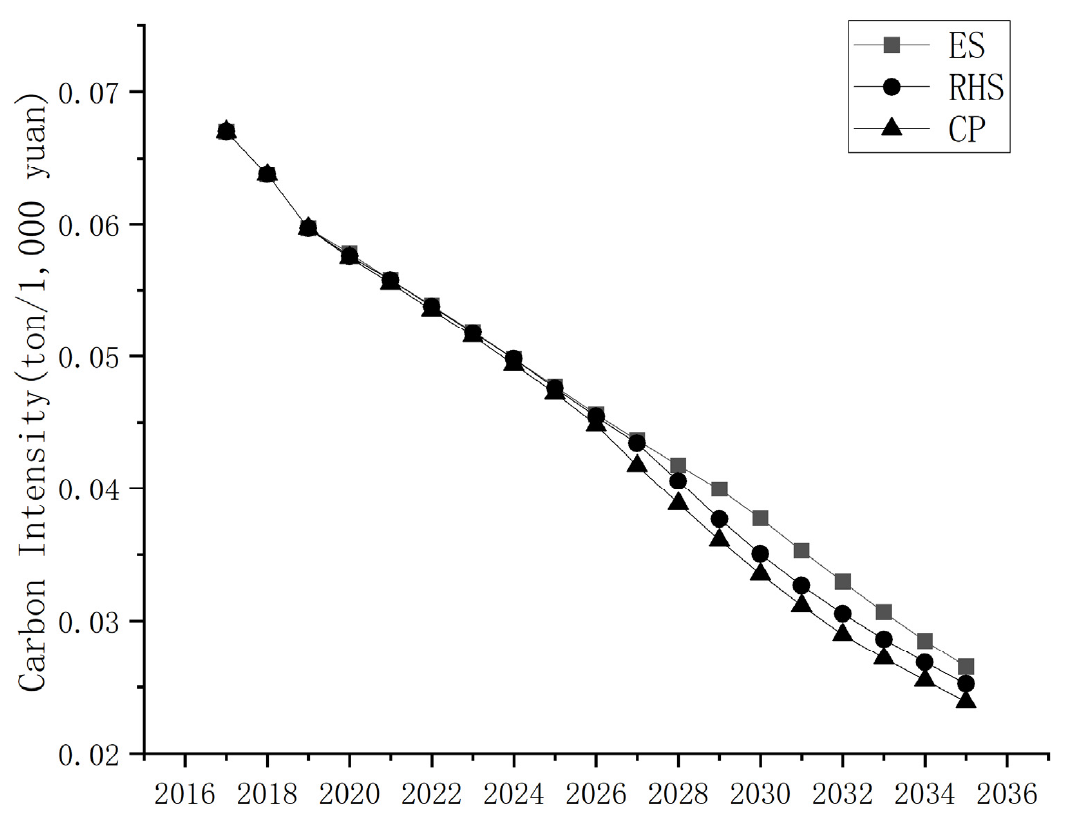
Figure 10. Carbon intensity change in different scenarios.